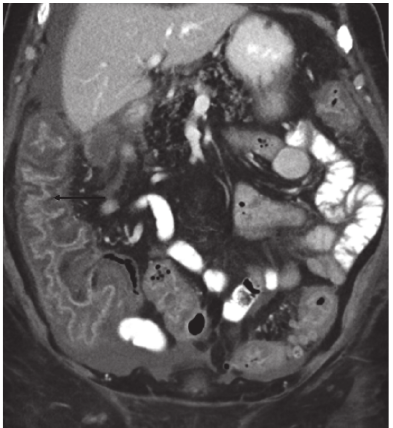
Figure 1: Sagittal view of CT scan of the abdomen showing ascending colon thickening